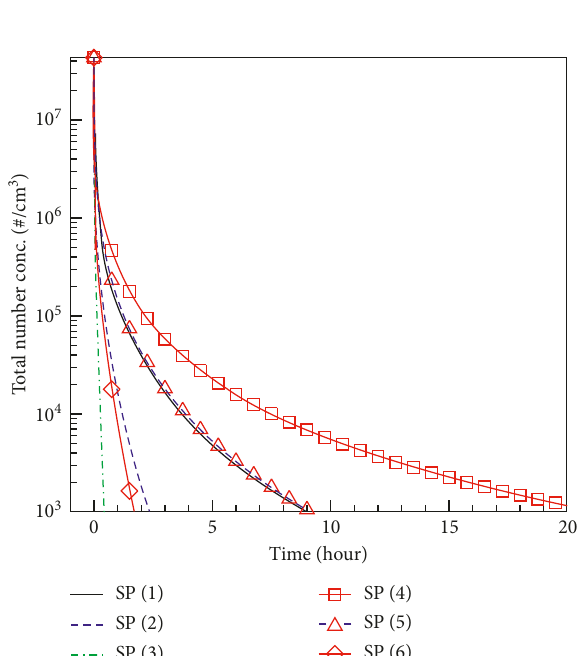
Figure 6: Change of total particle number concentration of SP mode at different initial SP mode and the same BP